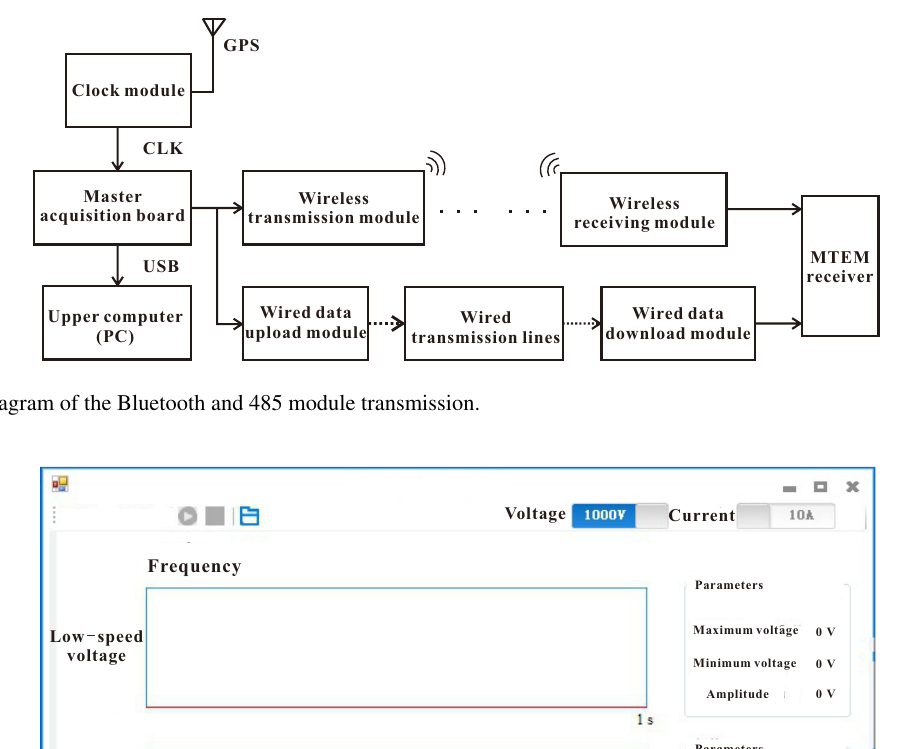
file onto the serial flash, EPCS16. After the FPGA is powered up again, in the active serial mode, it reads the configuration file in the external serial flash internally and completes the IC configuration